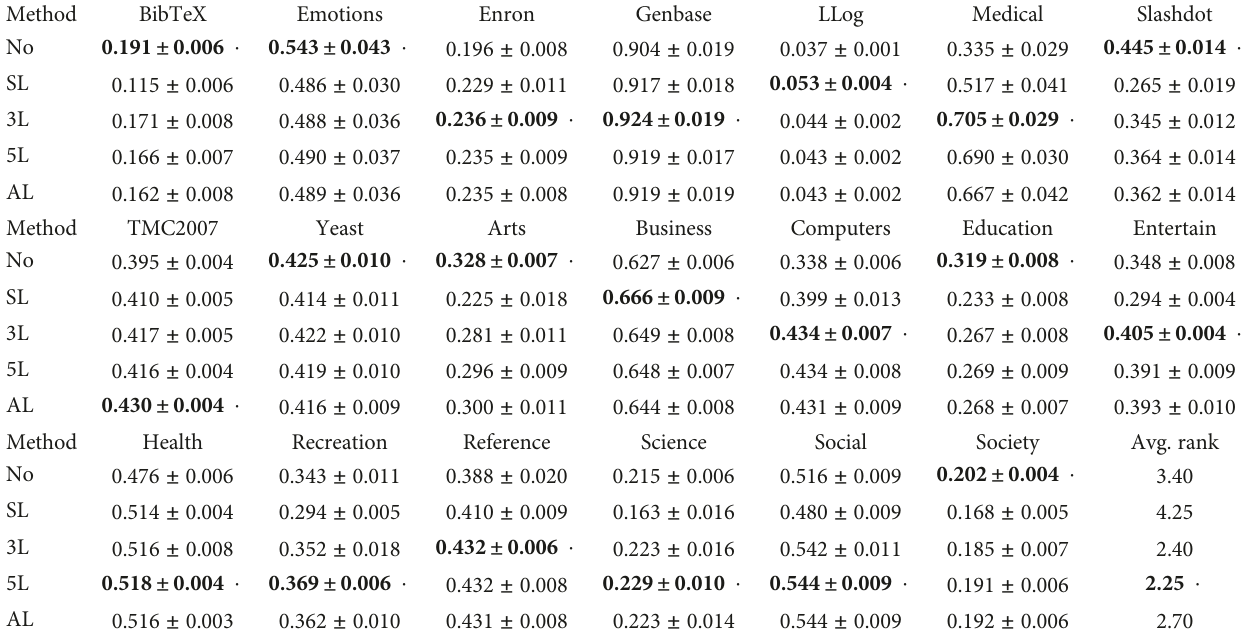
Table 4: Multilabel accuracy ( ↑ ) performance of each comparing method (mean ± std. deviation) on 20 multilabel datasets.